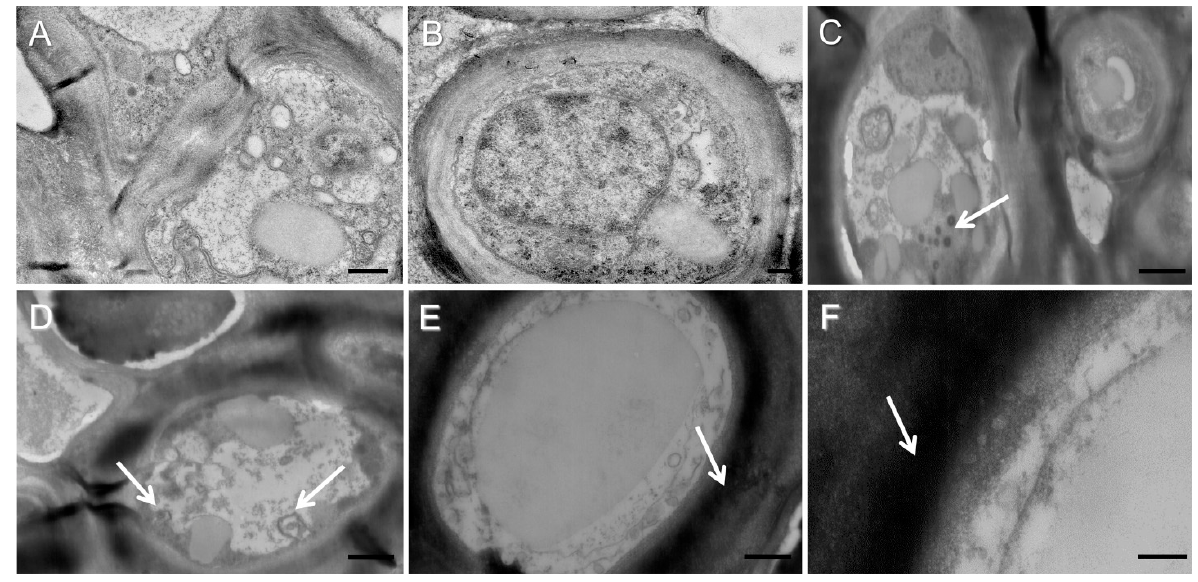
Figure 5. TEM images of non-melanized thalli ( A , B ) and the stages of melanization in melanized thalli of Lobaria pulmonaria ( C – F ): ( C )—accumulation of melanosome-like vesicles. ( D )—merging vesicles with plasma membrane. ( E , F )—electronically dense cell walls in melanized thalli. Arrows indicate melanin-like vesicles. Bar = 0.5 μ m ( A ), 0.2 μ m ( B ), 1 μ m ( C , D ), 0.5 μ m ( E ), 0.2 μ m ( F ).